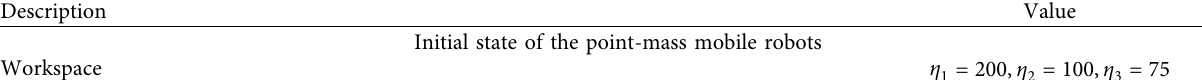
units of time, green sphere at t � 2110 units of time, and purple sphere at t � 8000 units of time. Table 3 provides all the values of the initial conditions, constraints, and dif- ferent parameters utilised in the simulation, if different